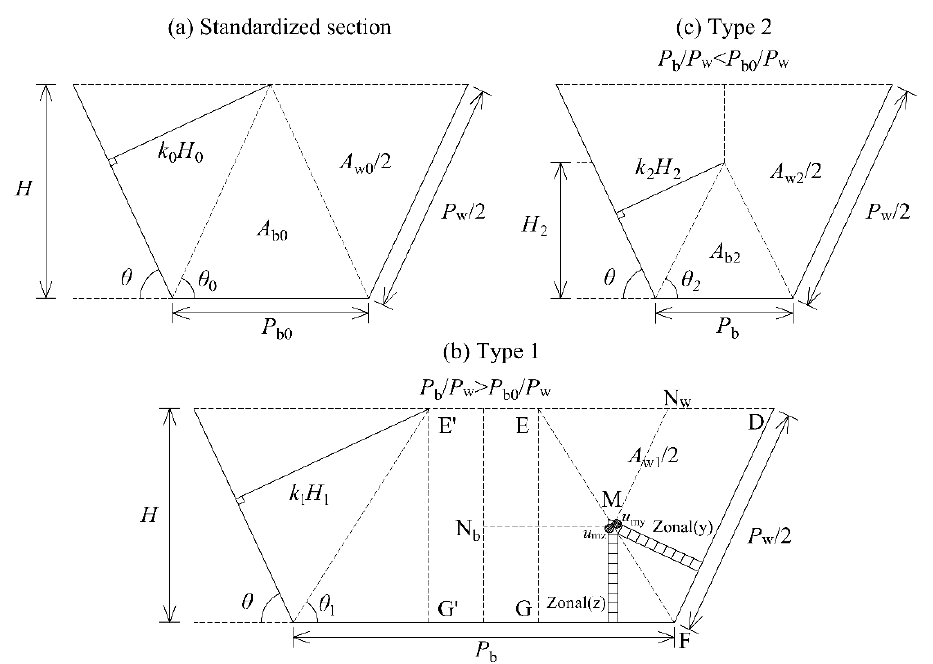
Figure 1. Partition model of a cross-section: ( a ) standardized section, ( b ) Type 1 section, and ( c ) Type 2 section.